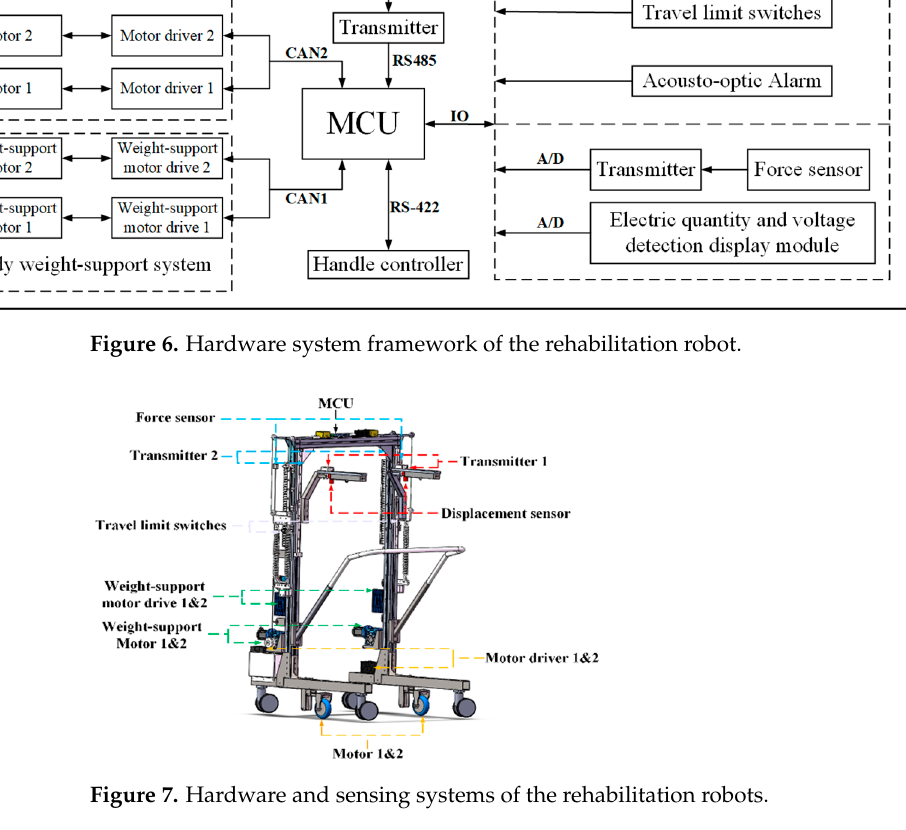
Figure 8. Operation flowchart for the remote system. The interactive interface of the rehabilitation robot is designed by LABVIEW soft- ware. (LABVIEW was developed by National Instruments Corporation, headquartered in Austin, TX, USA). The development interface consists of a front panel and a rear panel. The front panel includes a digital control, and a digital display. The interface information includes the robot’s operating status and various rehabilitation parameters, the patient’s personal information, remote real-time video images, and the movement data change curve during the patient’s rehabilitation. The back panel is a graphical representation of the control commands that implement the program structure and define the control logic. The feedback data from the robot sensors is filtered and noise-reduced in the control core MCU. This data is then converted to digital signals for direct display on the front panel of the interactive interface. The communication module allows the client computer system